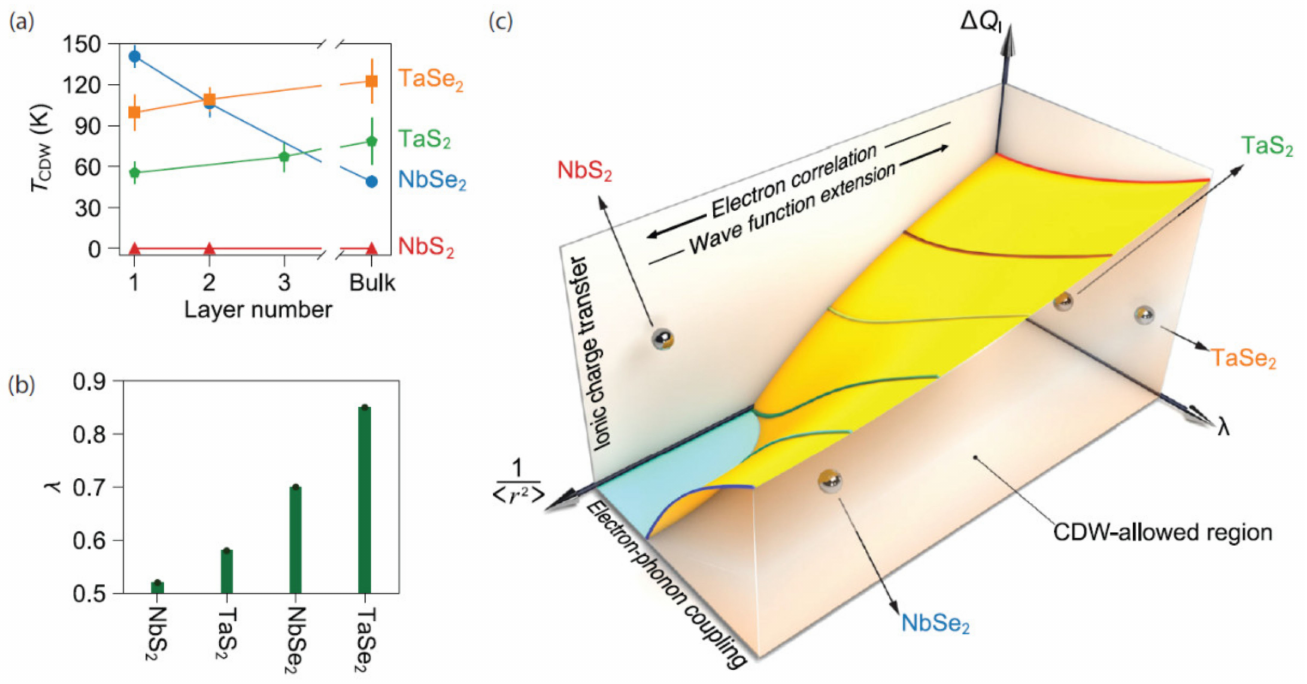
Figure 19. ( a ) Thickness dependence of the CDW transition temperature in 2 H -MX 2 . Error bars are standard deviations obtained from the least-squares fits to the temperature-dependent amplitude mode intensity. ( b ) The calculated values of electron–phonon coupling constant ( λ ) for monolayer 1 H -MX 2 . ( c ) Schematic illustration of the possible phase diagram describing the CDW response in a layered material in terms of ionic charge transfer ( ∆ Q I ), electron–phonon coupling constant ( λ ), and the spatial extension of electronic wave functions (1/<r 2 >). Reference [168] is an